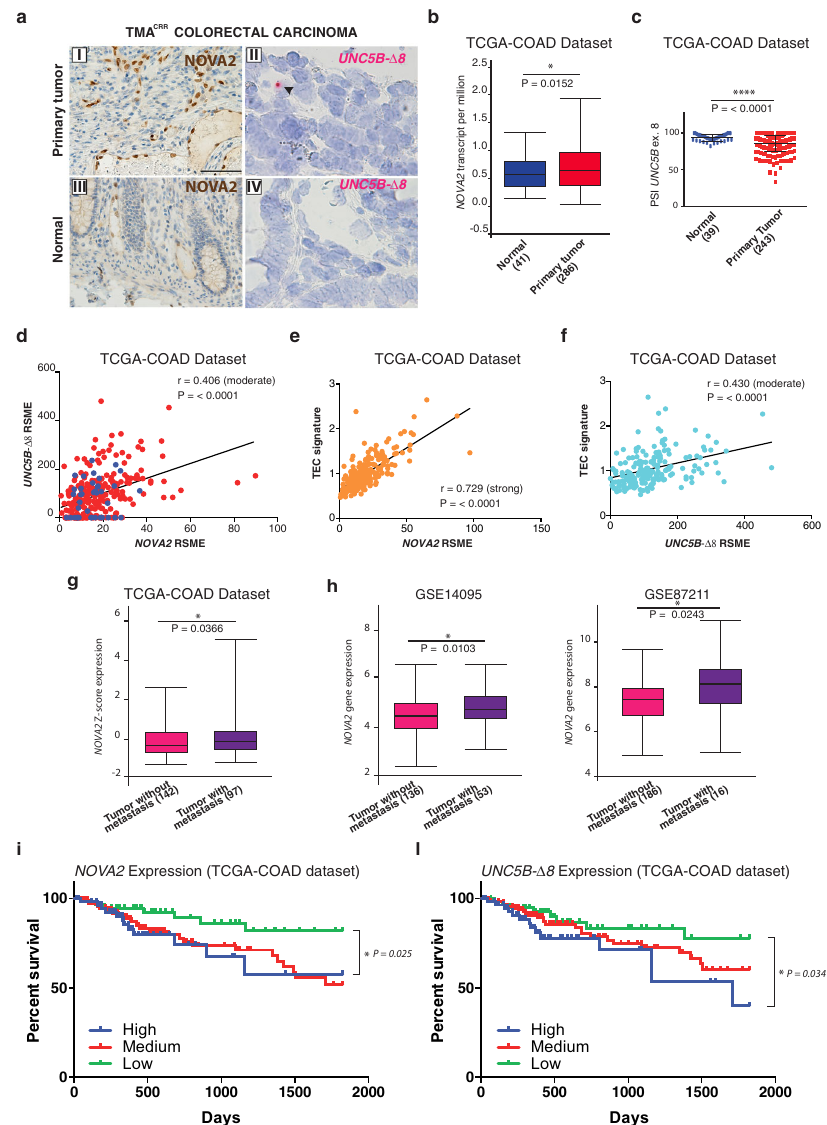
Fig. 5 NOVA2 and UNC5B- Δ 8 expression levels in colon cancer patients. a IHC of NOVA2 (I and III, scale bar: 60 μ m) and ISH with the UNC5B- Δ 8 probe (II and IV, scale bar: 30 μ m) in colon primary tumors and normal adjacent tissues. Black arrowheads indicate UNC5B- Δ 8 signal in ECs in tumor blood vessels. b RNA-seq data analysis of NOVA2 mRNA expression levels, c PSI (Percent Spliced-In) of UNC5B exon 8, and d correlation between NOVA2 and UNC5B- Δ 8 expression in normal (blue) and colon adenocarcinoma (red) samples in the TCGA-COAD dataset. e NOVA2 and f UNC5B- Δ 8 correlation with a colon tumor-speci fi c angiogenetic signature (TEC). g NOVA2 mRNA Z-score expression levels in colon adenocarcinoma without (N0) or with metastasis (N1 or N2) annotated in the TCGA-COAD dataset. h NOVA2 mRNA expression levels in colon adenocarcinoma without or with metastasis (GSE14095 and GSE87211 datasets; http://hcmdb.i-sanger.com). i Kaplan – Meier plot of 5-years overall survival in colon adenocarcinoma patients classi fi ed according to NOVA2 or l UNC5B- Δ 8 mRNA expression. Blue curve: high expression (1st quartile); red curve: moderate expression; green curve: low expression (3rd quartile). Log-ranked P -values are indicated. Boxplot represents upper quartile, median, lower quartile. Error bars indicate minimum and maximum. Two- tailed Log-ranked test (in b ) or Two-tailed Student ’ s t -test (in c and g ) and exact P values are indicated: * P < 0.05, **** P < 0.0001. P values in h , were calculated by HCMDB platform. For correlation analysis, linear regression (black line) and Pearson r coef fi cient with two-tailed P -value were also calculated. a key determinant during capillary morphogenesis and apoptosis is relatively well known, much remains to be under- remodeling 13,14,65,66 , and its inhibition reduces angiogenesis stood about how these pathways are regulated during physiolo- gical and pathological angiogenesis. in vivo 14,65 . In particular, a role for apoptosis in controlling EC number, capillary diameter during angiogenic vessel growth, and Here we describe an alternative splicing variant of the dependence maturation has been reported 55 . Moreover, EC apoptosis is receptor UNC5B (UNC5B- Δ 8) that is produced in ECs, is insensitive instrumental in lumen formation during in vitro vessel-like to the prosurvival activity mediated by Netrin-1, and regulates vessel structure formation 52 and in vivo, where apoptotic ECs have been formation in an apoptosis-dependent and vascular beds-speci fi c found during placenta vasculogenesis and angiogenesis manner. These fi ndings further support the notion that EC apoptosis processes 53 . While the molecular machinery executing EC plays an important role during blood vessel morphogenesis 67 – 69 . NATURE COMMUNICATIONS| (2021) 12:4872